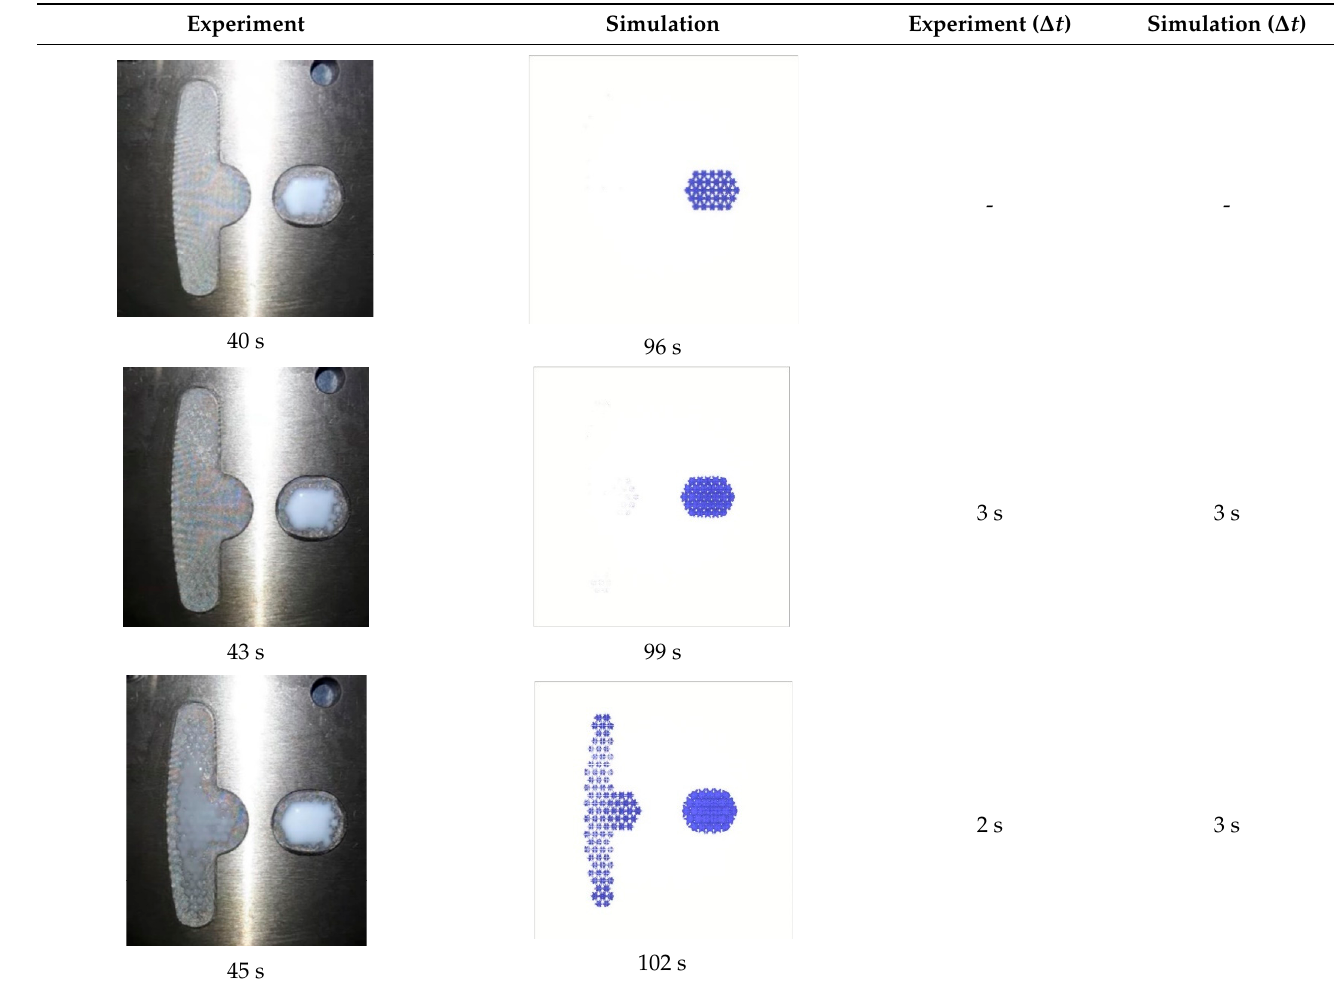
Table 6. Experimental and simulation results of the Case 1 flow trend on the plate.